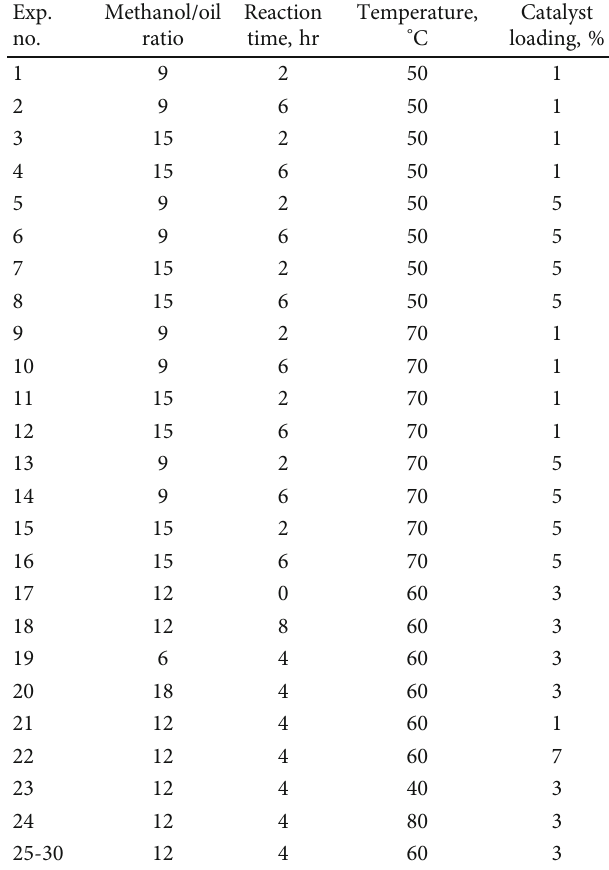
Table 3: Experimental runs.